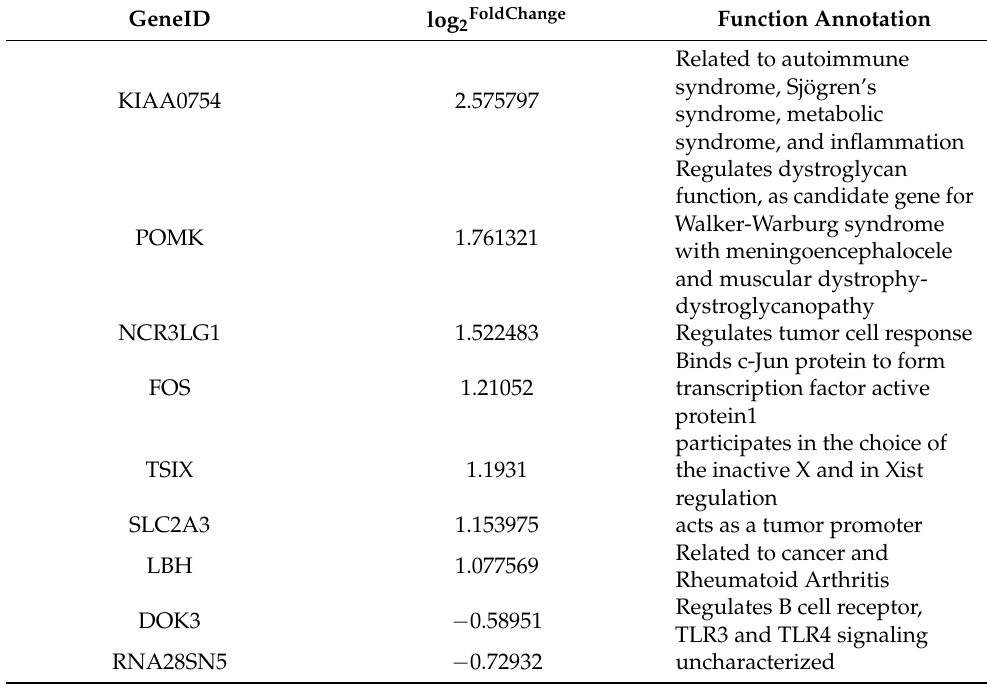
Figure 5. The volcano plot of differently expressed genes in LcASC overexpression samples. The red dots indicate the up-regulated genes, the blue dots indicate the down-regulated genes, and the grey dots indicate unchanged genes. Table 1. The function annotation of several important DGEs.